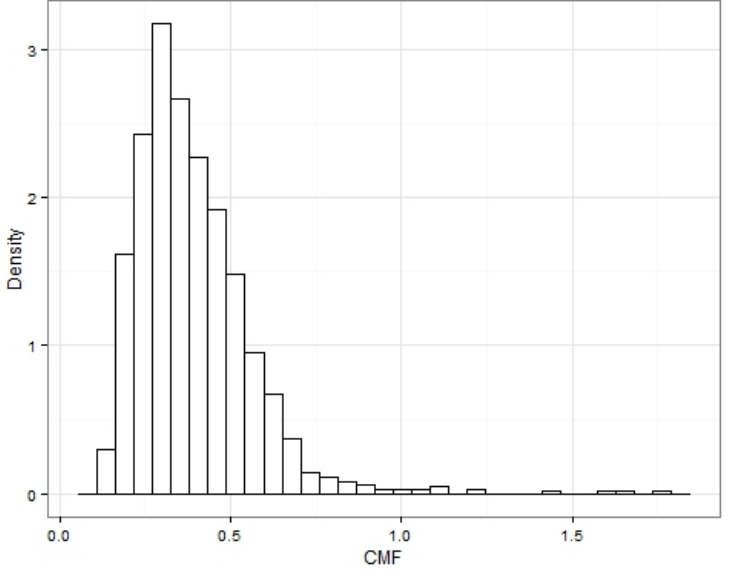
Figure 14. Histogram of the constant motion factor for the macro